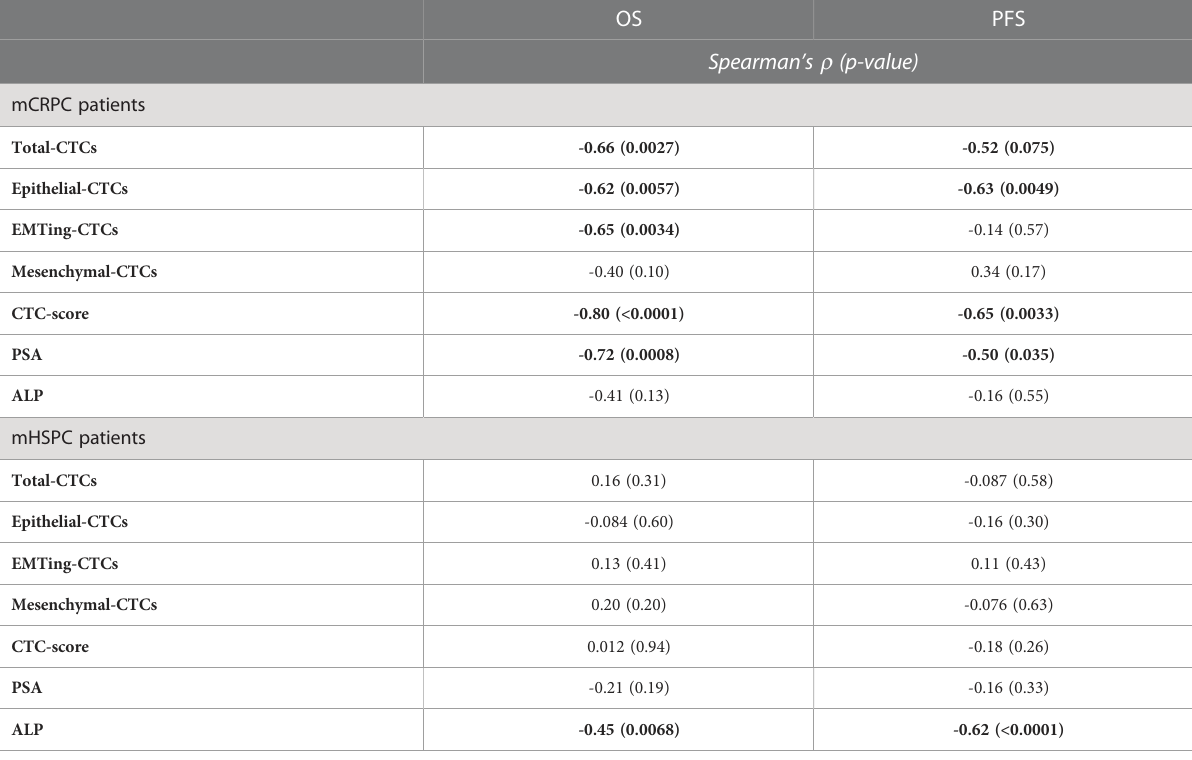
TABLE 3 Spearman ’ s correlation of CTCs and serum biomarkers with OS and PFS.